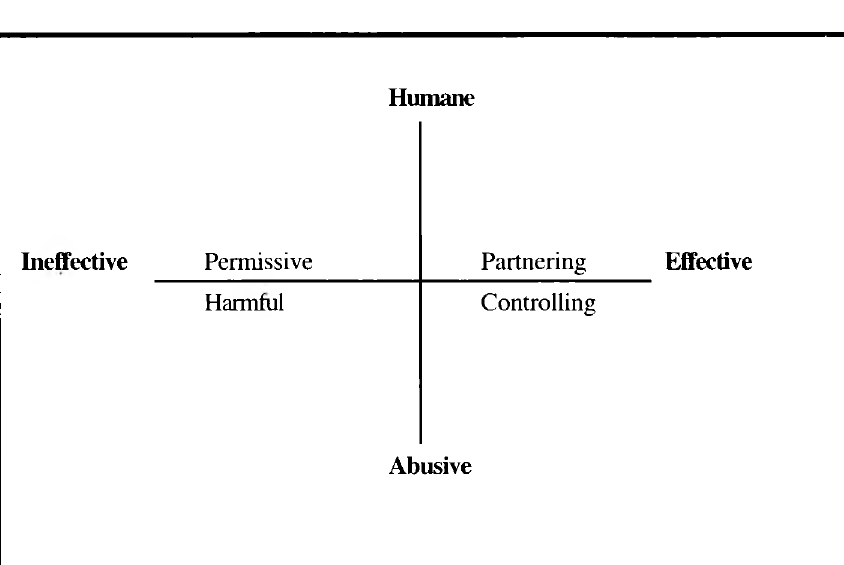
Diagram 1: Humane, & Effective Response Options (HERO)